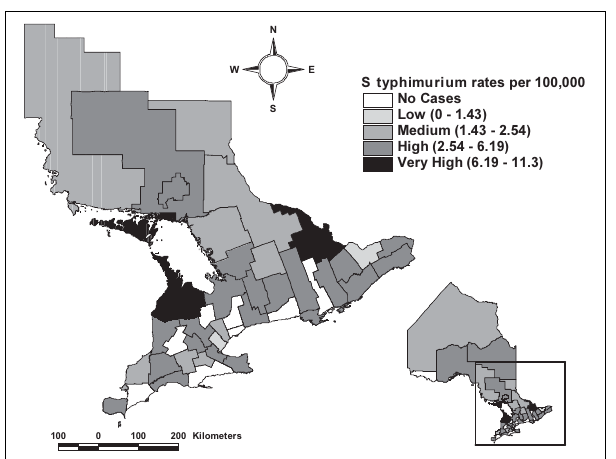
TABLE 4 Frequency distribution of multiresistant patterns*